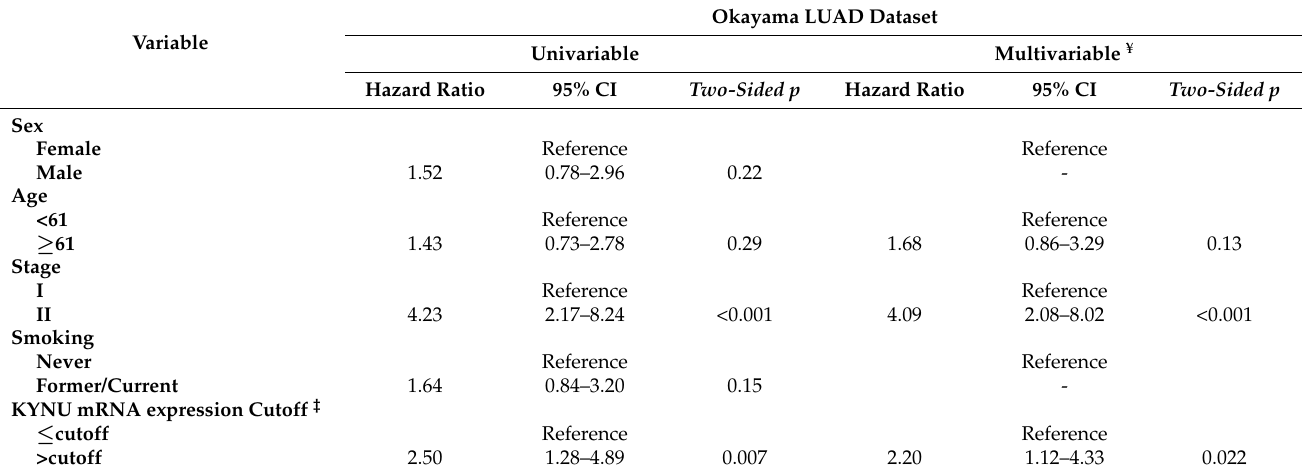
Table A5. Univariate and multivariate Cox proportional hazard odels for KYNU mRNA expression in the Okayama lung adenocarcinoma gene expression